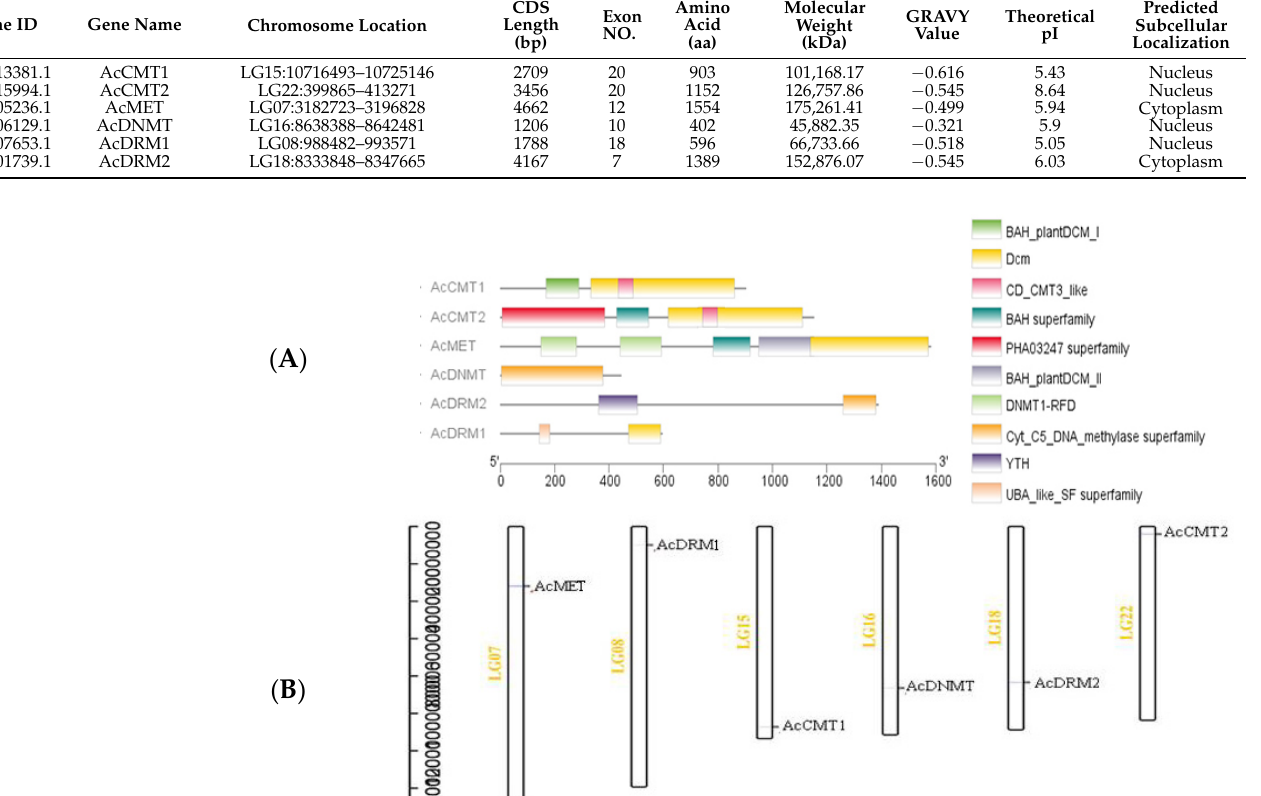
Table 2. Overview of C5-MTase genes identified in pineapple.